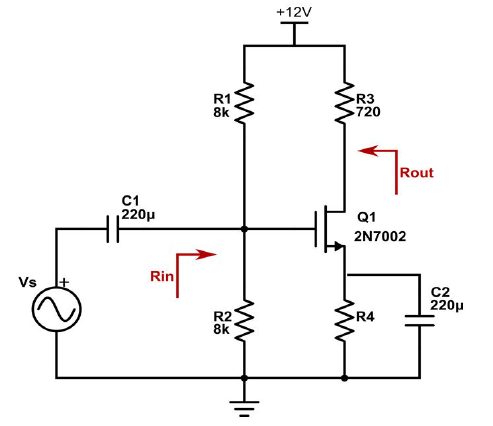
Figure 3. Schematic of the MOS amplifier circuit given in question